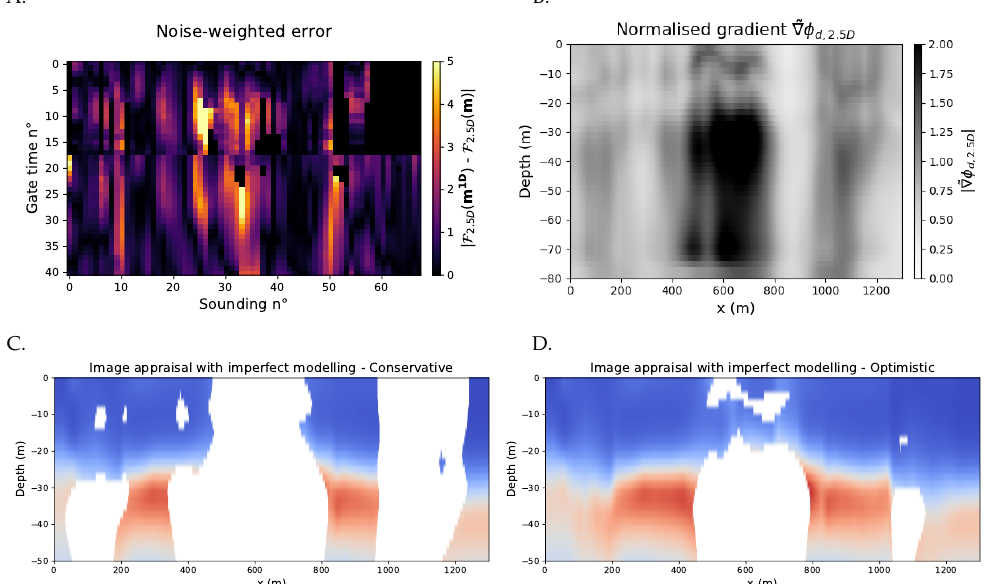
Figure 7. Image appraisal on real field data with imperfect forward modeling approach. The individual noise-weighted errors in ( A ) do not include observed noise. The normalised gradient ( B ) for different cut-off values are shown in ( C , D